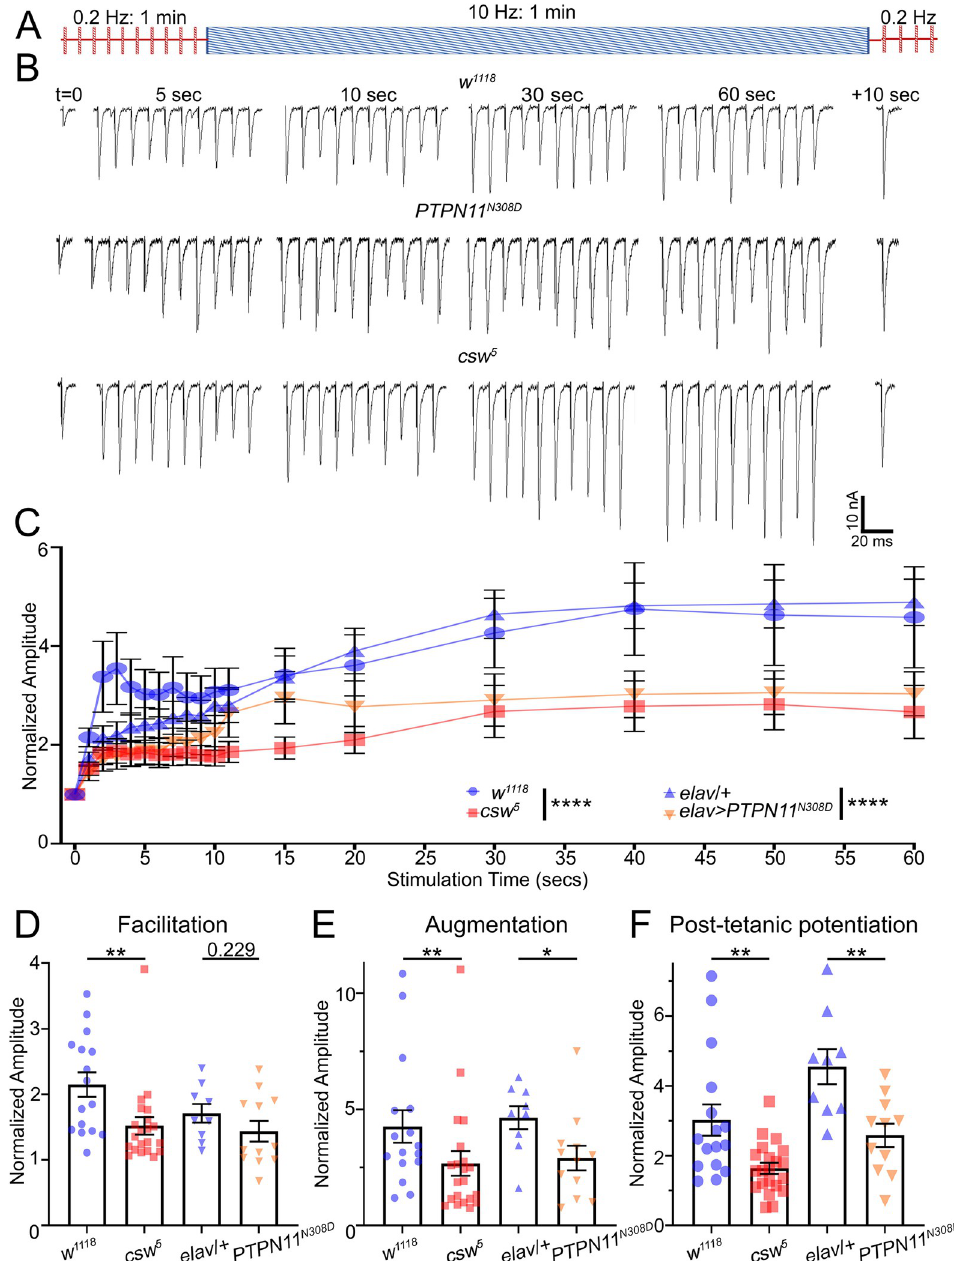
Fig 4. Activity-dependent synaptic plasticity repressed in csw / PTPN11 mutants. Synaptic plasticity during and following a short-term stimulation train to measure facilitation, augmentation, and PTP. ( A) Stimulation paradigm: 1 minute at 0.2 Hz (0.2 mM Ca 2+ ), followed by 1 minute at 10 Hz, and then a return to 0.2 Hz. ( B) Sample EJC traces at indicated time points during and following the 10 Hz train for control ( w 1118 , top), GoF PTPN11 N308D ( elav - Gal4 > PTPN11 N308D ; middle), and csw null ( csw 5 , bottom). ( C) Quantification of EJC amplitude during the 10-Hz train normalized to basal EJC amplitude for each genotype. The nonlinear regression exponential for each pair tested using extra sum-of-squares F test. ( D-F) Quantification of facilitation (1 second, D ) and augmentation (30 seconds, E ) during the 10-Hz train, and PTP (10 seconds following train, F ) normalized to the basal EJC amplitude for each genotype using Mann–Whitney/two-sided t tests. Scatter plots show all data points and mean ± SEM. N = number of NMJs. Significance: p < 0.05 ( � ), p < 0.001 ( �� ), and p < 0.0001 ( ���� ). The data underlying this figure can be found in S1 Data. csw , corkscrew; EJC, excitatory junction current; GoF, gain-of-function; NMJ, neuromuscular junction; PTP, post- tetanic potentiation; PTPN11 , protein tyrosine phosphatase non-receptor type 11.